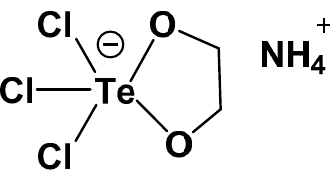
Figure 9. Chemical structures of AS101.